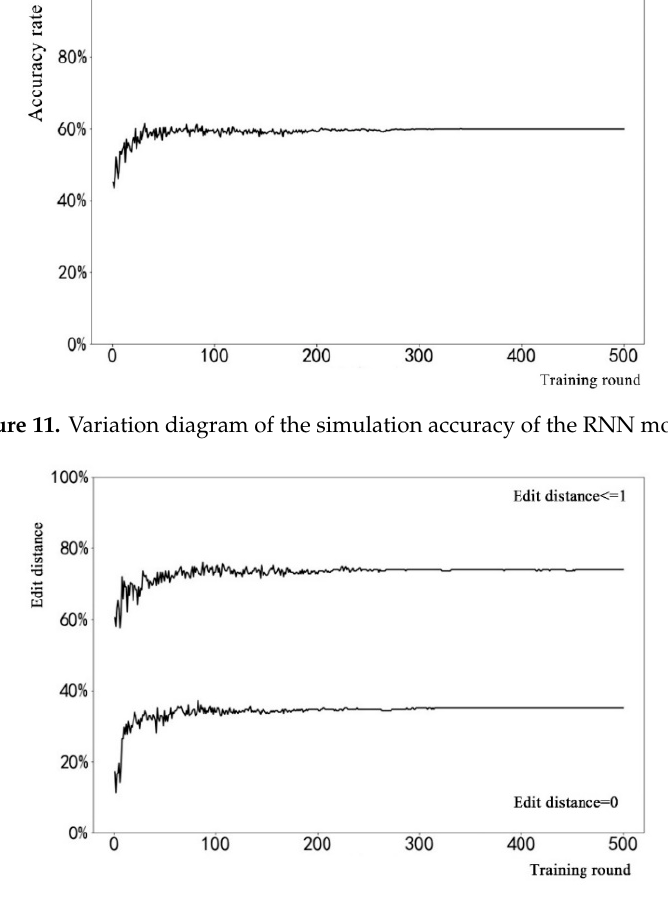
Figure 12. Variation curve of the geostratigraphic series edit distance with time.